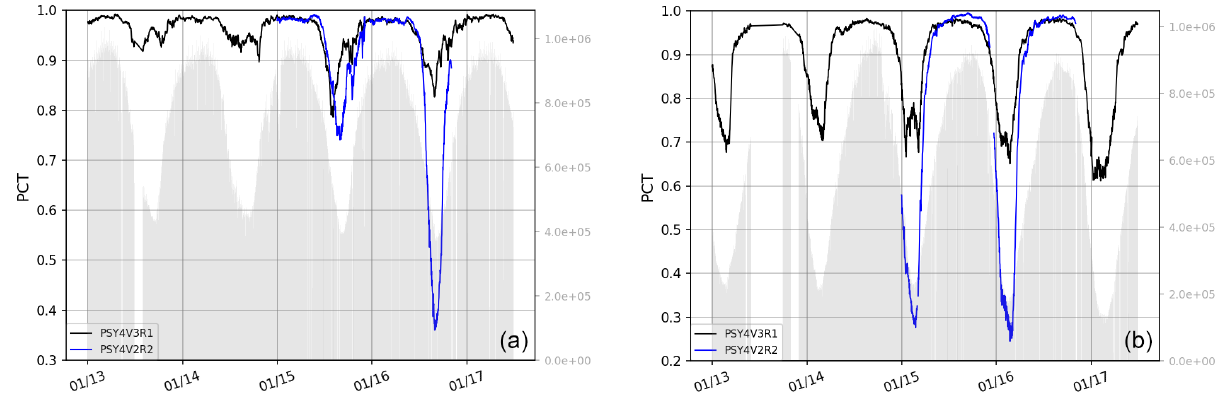
Figure 28. Time series of the PCT quantity for PSY4V2 (in blue) and PSY4V3 (in black). (a) Corresponds to the Arctic and (b) to Antarctic. Time series of the number of available observations appear in grey.